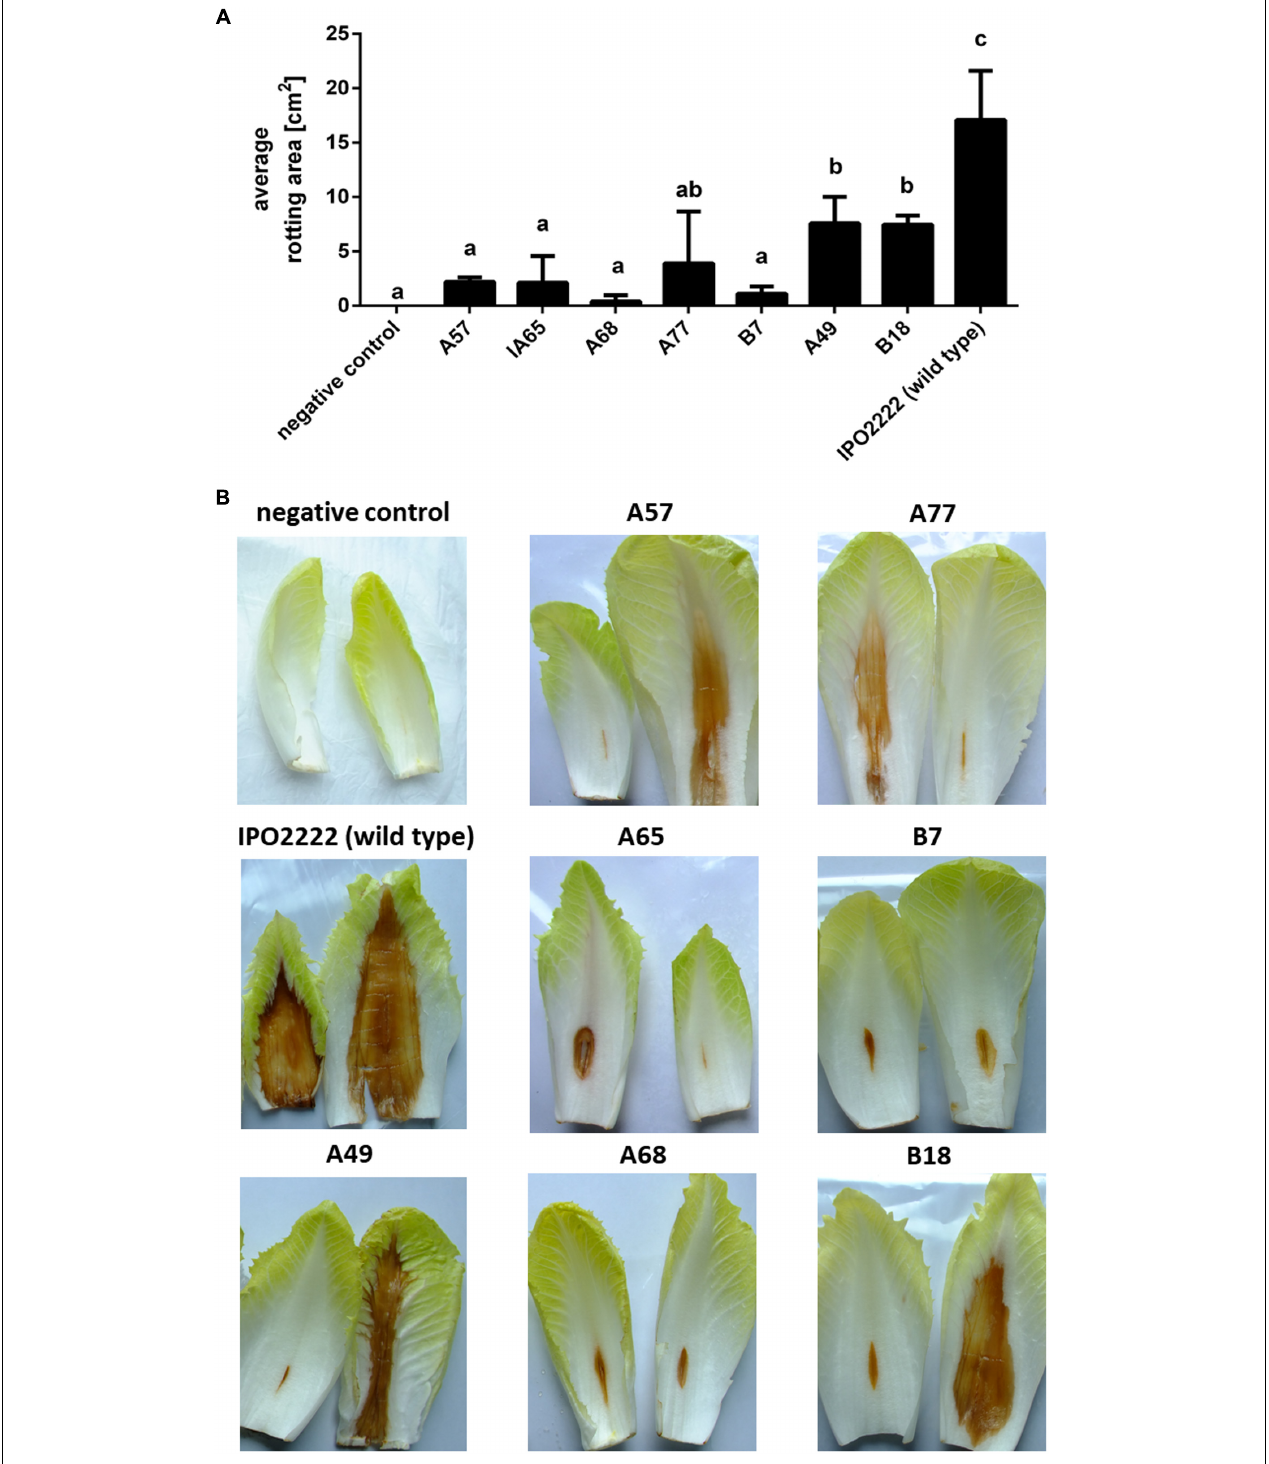
FIGURE 3 | Ability of seven Dickeya solani IPO22222 Tn5 mutants to cause maceration of chicory leaves. Quantitative determination of the average area of rotting (in cm 2 ) after 48 h incubation at 28 ◦ C in a humid box. Per mutant, five individual chicory leaves were inoculated in two independent experiments ( n = 10). Results were considered to be significant at p = 0.05 and pair-wise differences were obtained using the t -test. Error bars represent standard deviation (SD) (A) and visual estimation of symptom expression in chicory leaves inoculated with individual IPO2222 Tn5 mutants or wild type (IPO2222, control) in Ringer’s buffer (Merck) after 48 h incubation in a humid box (B)